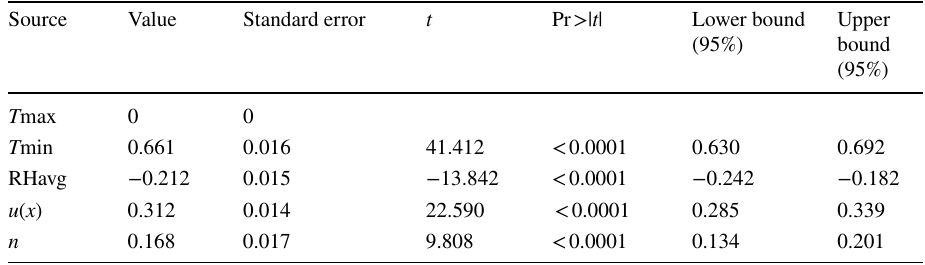
Table 6 RMSE, NSE, WI, and r for meta-heuristics algorithms-based models during the training and testing span at Faisalabad